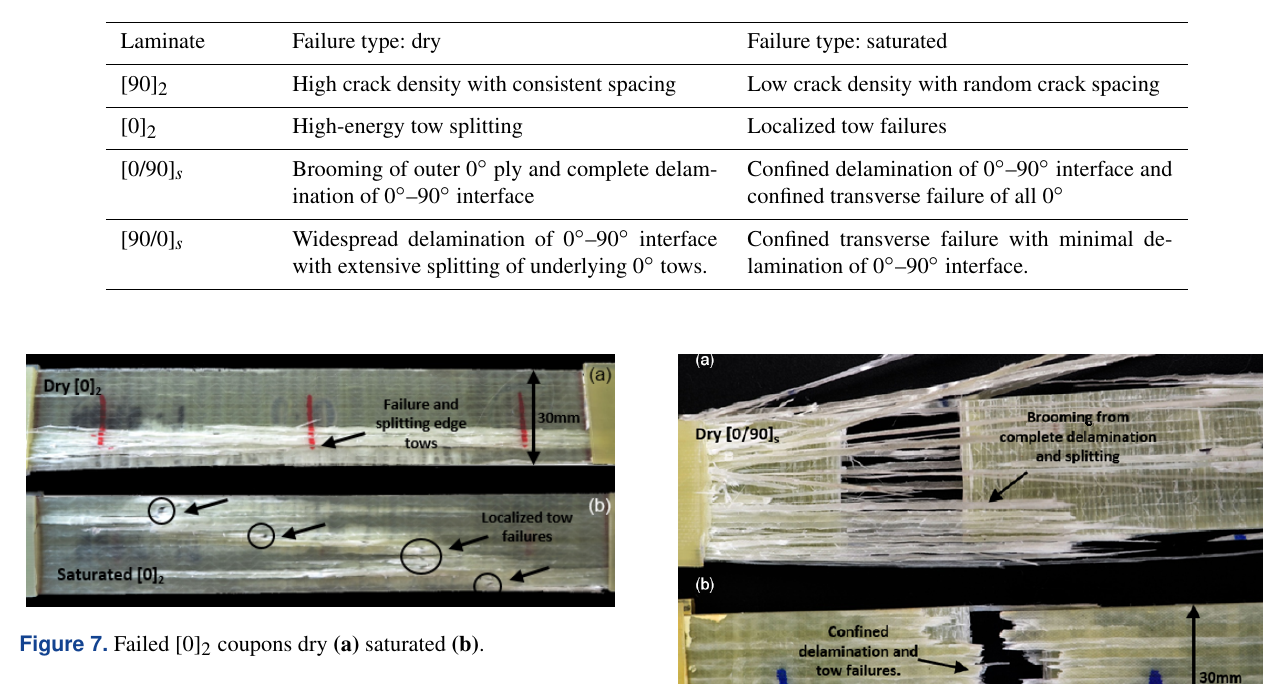
Table 1. Failure inspection results summary.